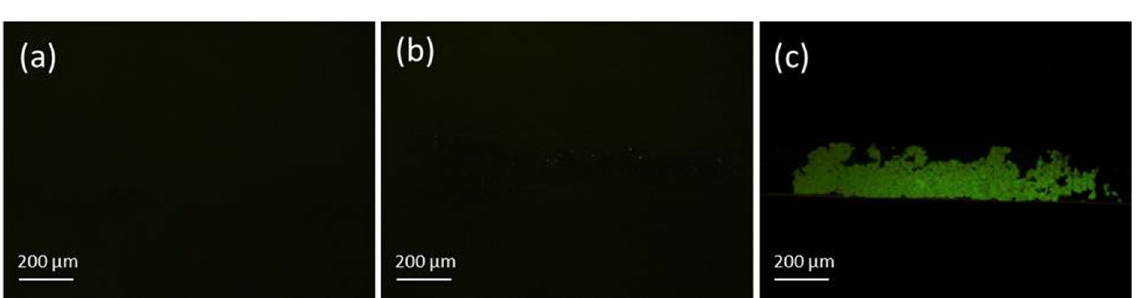
Figure 9. The response of the assay for PSMA antigen in the range of 0.7–20 nM, showing the detection limit of 0.7 nM.